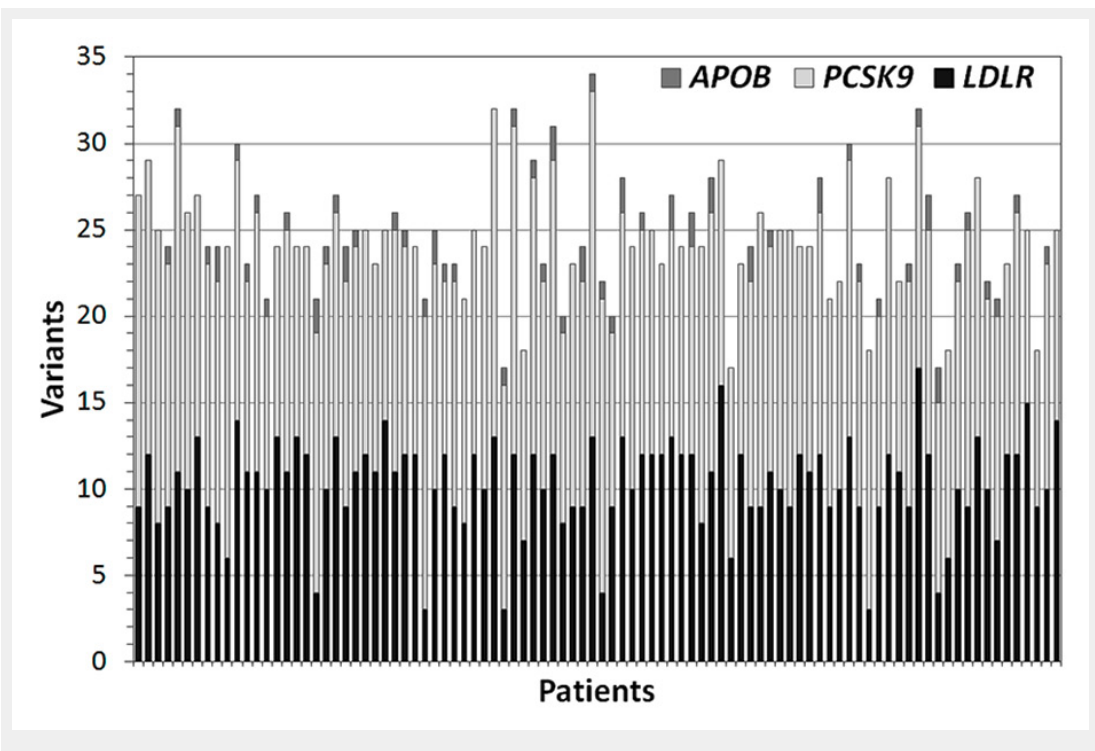
Figure 3 Number of variants identified in each of the 94 patients for APOB , LDLR , and PCSK9 . Each bar corresponds to a single